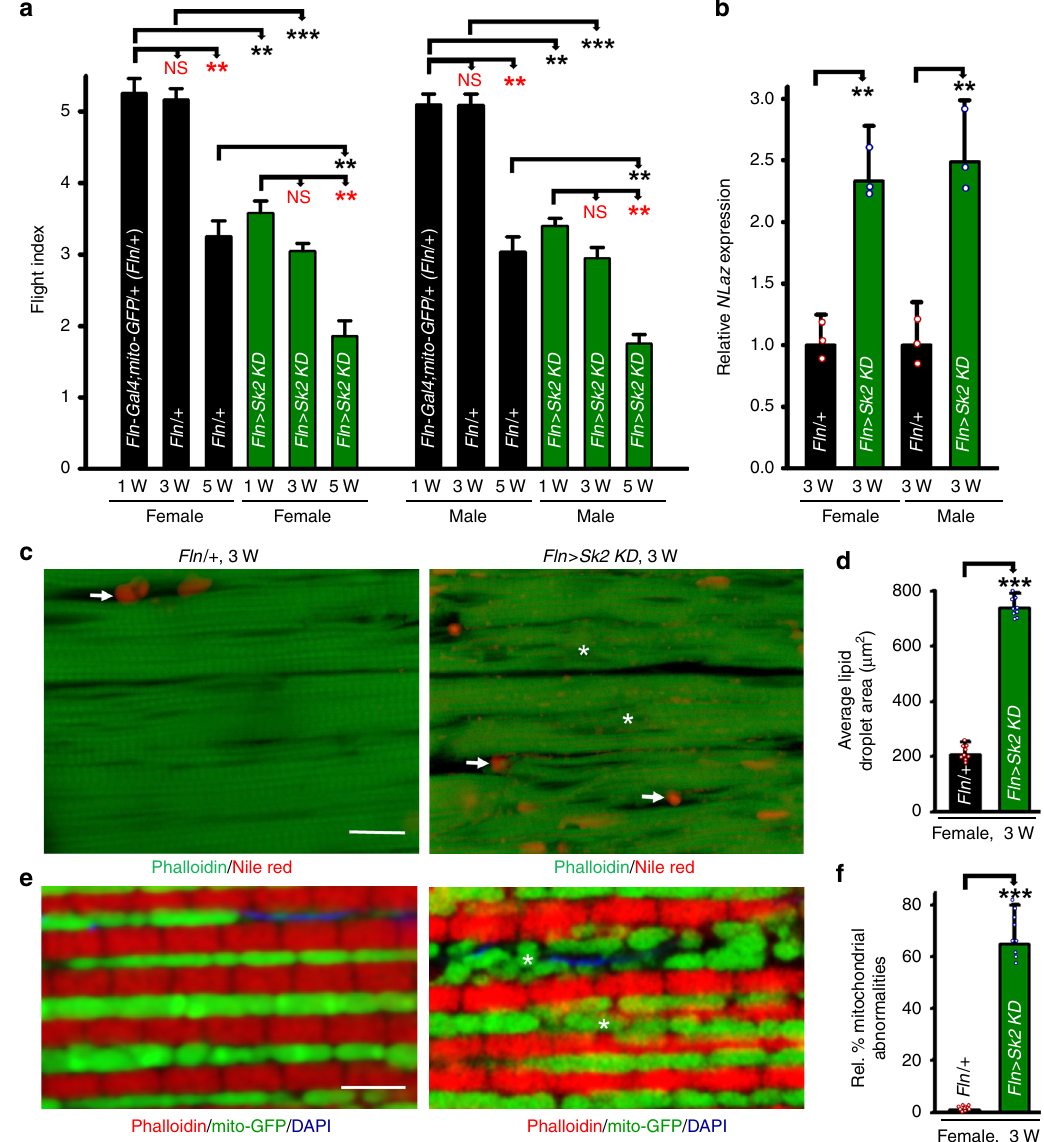
Fig. 3 Muscle-speci fi c knockout of Sk2 resulted in physiological dysfunction, like the Sk2 mutant. a Flight performance assay. Fly fl ight paths were recorded and given a numerical value to calculate fl ight index (F.I.) (see the Methods section). IFM-speci fi c RNAi knock-down of Sk2 using Fln-Gal4;UAS-mito-GFP (referred as Fln/ + ) resulted in a signi fi cant reduction in muscle performance in 1-, 3-, and 5-week-old male and female fl ies compared with age-matched driver control ( Fln/ + ) . Age-dependent decline in fl ight performance is also shown in the Sk2 KD and driver control fl ies. ( n = 100 – 150 fl ies were tested at each age in both male and female fl ies for the Sk2 KD and control fl ies from three independent experiments). b NLaz RNA was upregulated in the IFM upon KD of Sk2 in the genetically obese fl ies (both male and female) after 3 weeks. N = 3 independent experiments from 30 fl ies IFM. c Confocal images of the IFM from 3-week-old females of wild-type ( Fln/ + ) and IFM-speci fi c KD of genetically obese Sk2 fl ies probed with phalloidin (green) and Nile Red (red puncta). More intramuscular lipid (arrows) and actin-containing myo fi brillar disorganization was detected in IFM of Sk2 KD (asterisks), compared with age-